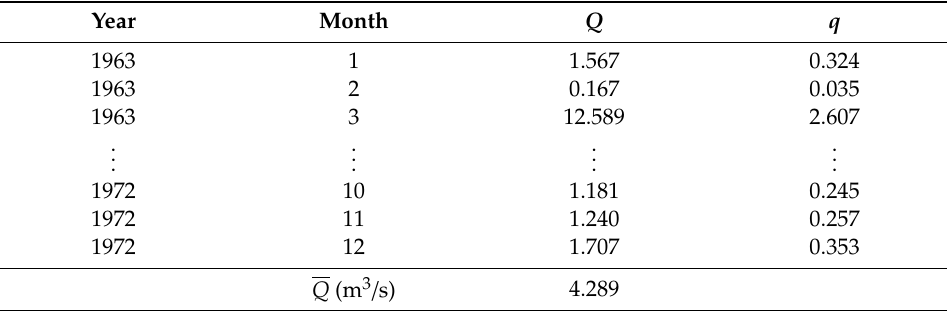
Table 5. Nondimensionalization of monthly streamflow data (D20A019).